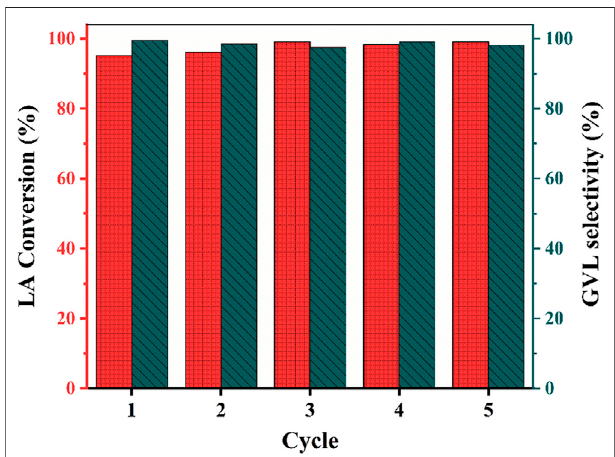
FIGURE 4 | Cyclic stability test of the Zr 1 Y 1